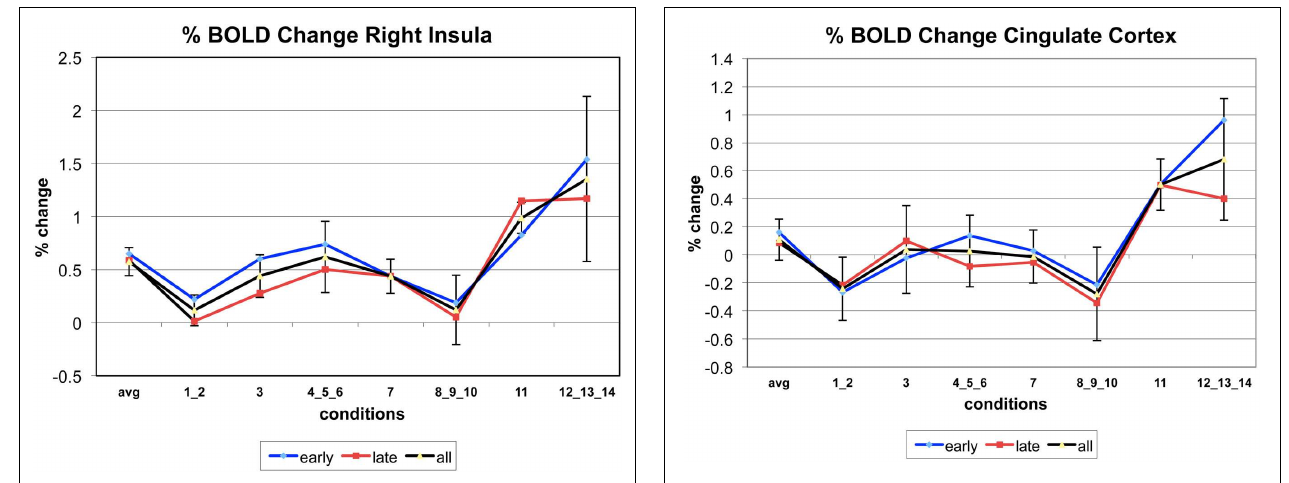
FIGUREA7 |Time series of percentage BOLD change for